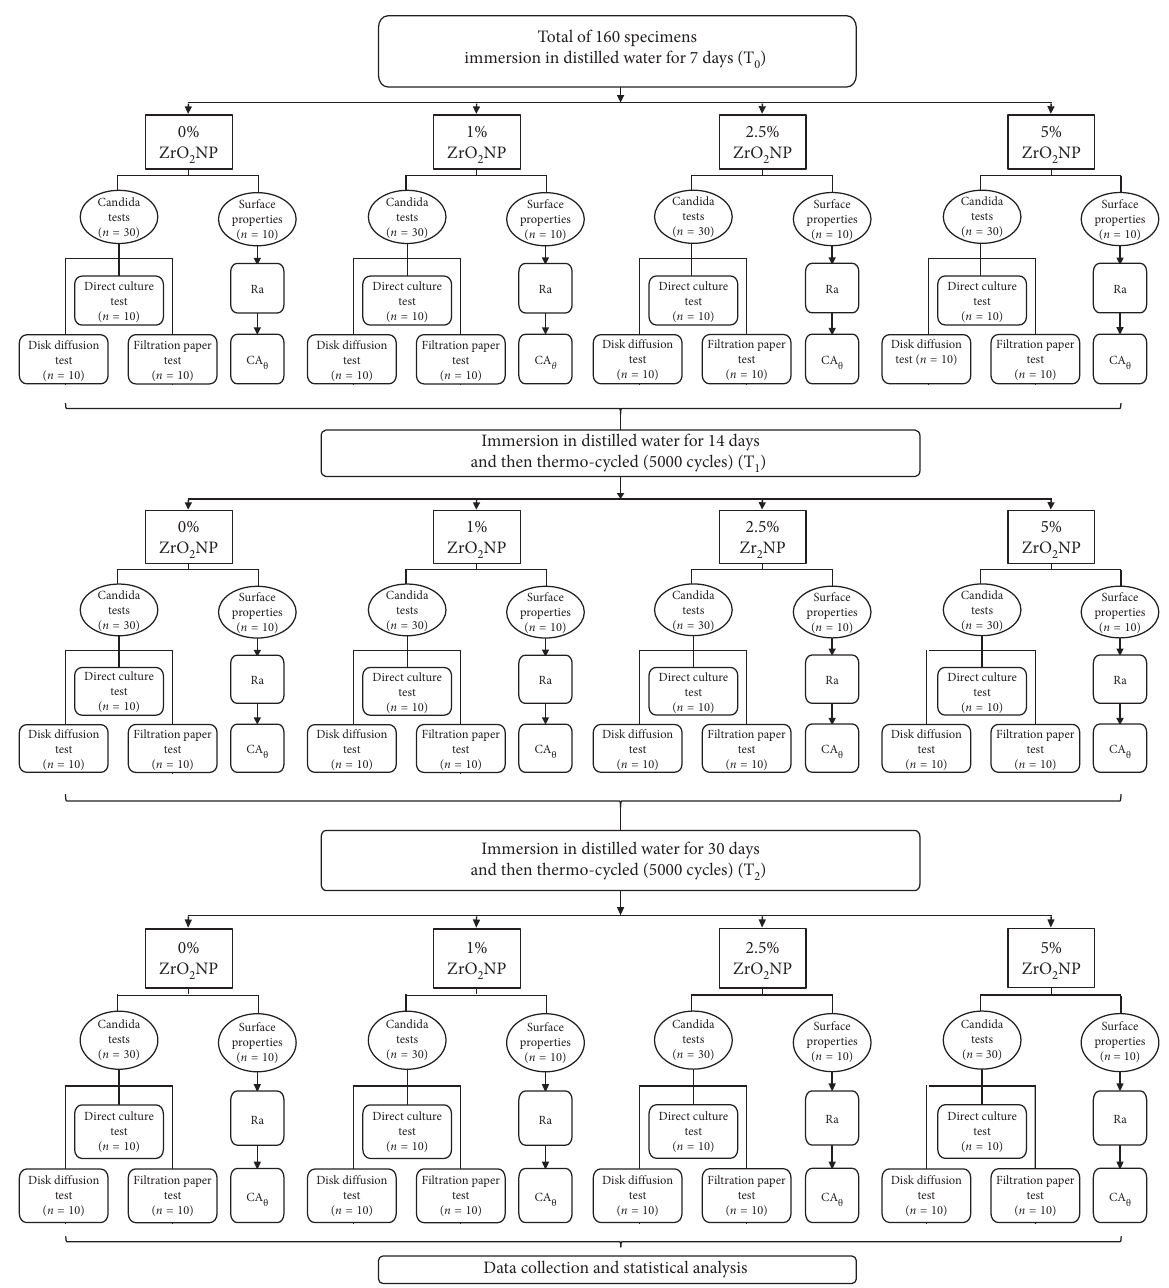
Figure 1: Flow diagram to illustrate study design. (CA) Candida adhesion; (Ra) surface roughness; (CA intervals of 7, 14, and 30 days,